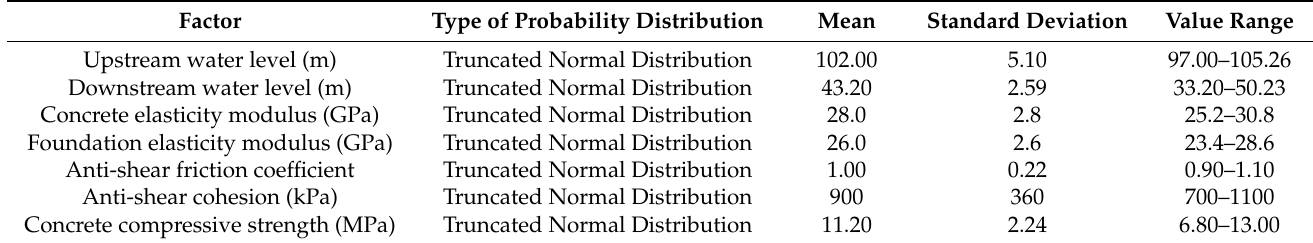
Table 1. Statistical characteristic and value ranges of the considered